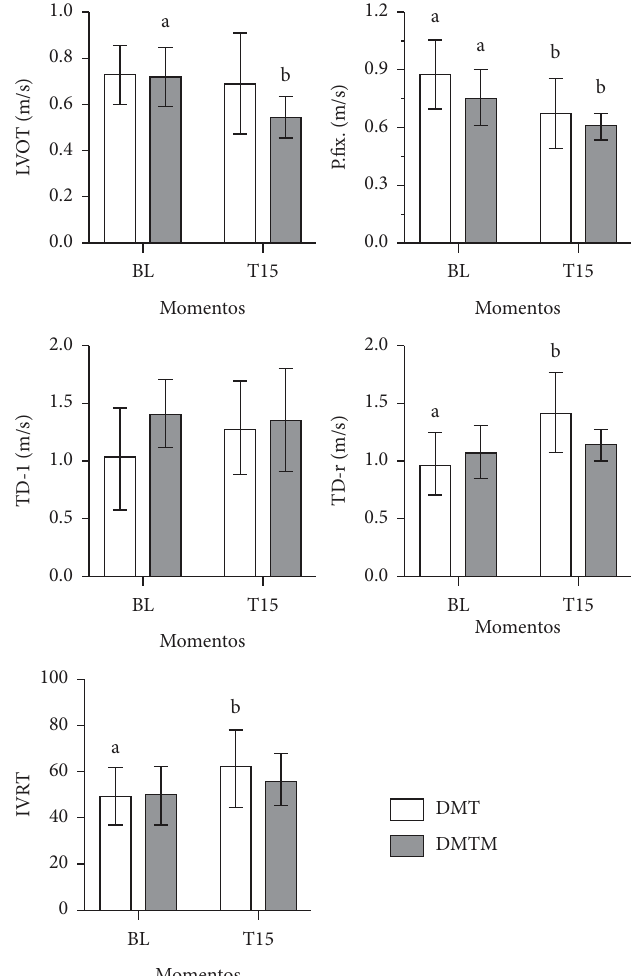
Figure 6: Values of left ventricular outfow tract (LVOT) velocity, pulmonary artery fow (P. fx), isovolumic relaxation time (IVRT), left tissue Doppler (TD-l), and right tissue Doppler (TD-r), in 18 felines sedated with the combination of dexmedetomidine (7.5ug/kg) and methadone (0.3mg/kg) (DMT, n � 9) or dexmedetomidine (5ug/kg), methadone (0.3mg/kg), and midazolam (0.3mg/kg) (DMTM, n � 9), both by the intramuscular route. Values are presented as mean ± standard deviation. a, b: diferent lowercase letters indicate a signifcant diference between moments within the same group according to the Tukey test ( p < 0 .